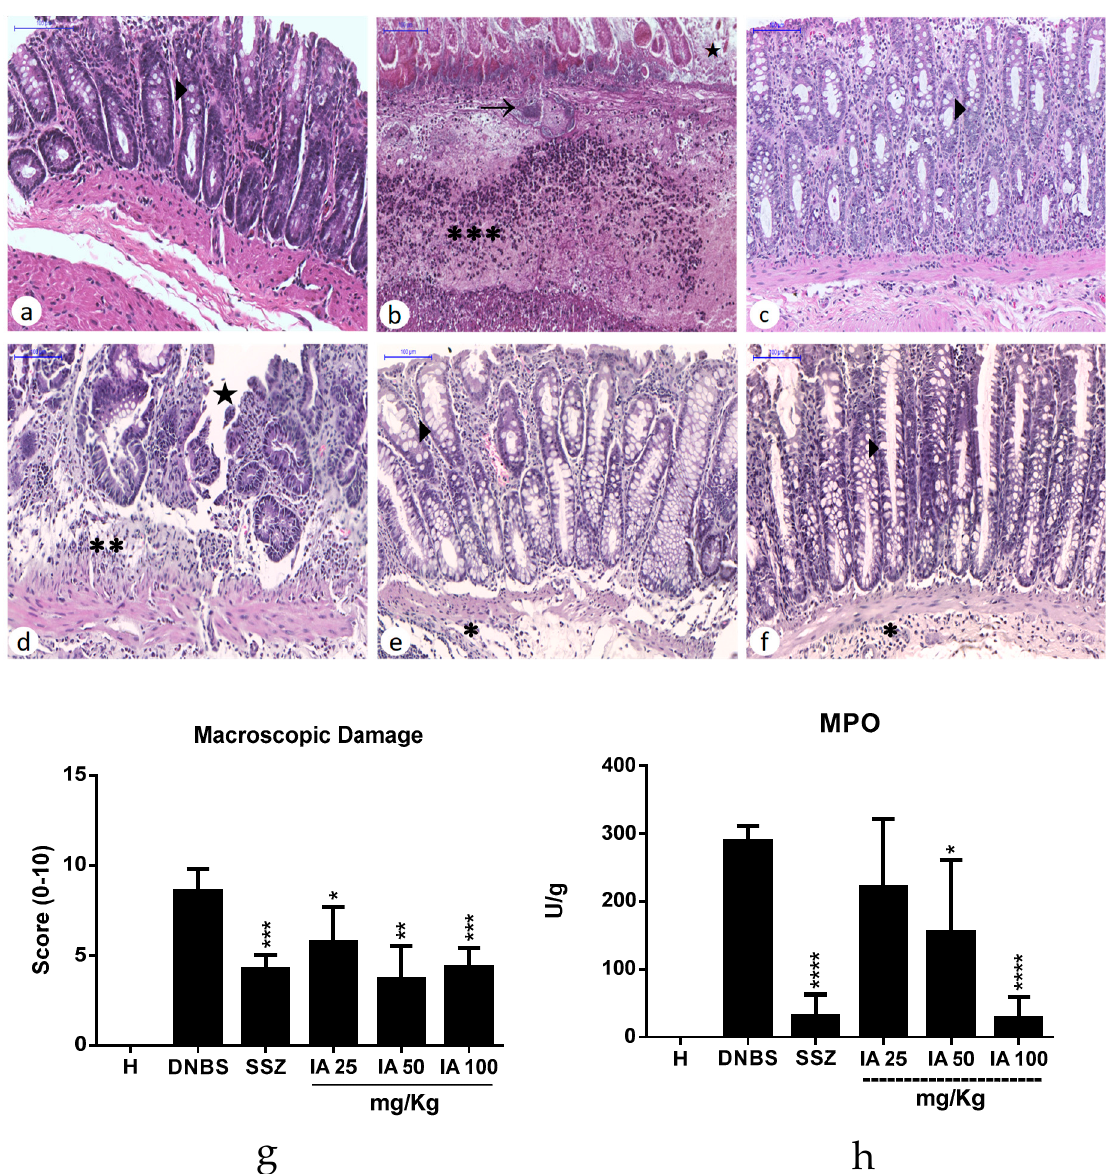
Figure 5. Histopathological analysis of the effect of the I. asarifolia (IA) aqueous extract at doses of 25, 50, and 100 mg/kg, and sulfasalazine (SSZ) at 250 mg/kg on intestinal colon mucosa in the experimental trial of acute colitis induced by 2,4-dinitrobenzene sulphonic acid (DNBS) in rats. Healthy group ( a ), exhibiting normal colonic mucosa with the presence of intact epithelium and numerous goblet cells; DNBS group (DNBS) ( b ), demonstrating the loss of epithelial integrity, intense inflammatory infiltrate ( ∗∗∗ ), focal necrosis ( → ) and ulceration ( (cid:70) ); Sulfasalazine group ( c ), with characteristics similar to the saline group; IA dose of 25 mg/kg ( d ) presented areas with loss of epithelial integrity and moderate inflammatory infiltrate ( ∗∗ ); IA dose of 50 mg/kg ( e ) and IA dose of 100 mg/kg ( f ) exhibited better organized colonic epithelial tissue, similar to the saline group, and presented areas with loss inflammatory infiltrate ( ∗ ). The arrow heads ( ► ) represent the goblet cells. Microscopic score of treatments vs. DNBS control ( g ). Myeloperoxidase activity (MPO) ( h ). H, Healthy group; DNBS, DNBS group; SSZ, Sulfasalazine group; and 25, 50, and 100 mg/kg doses of IA. Data are expressed as mean ± SEM, ( n = 5). Statistical differences * p < 0.05, ** p < 0.01, *** p < 0.001 and **** p < 0.0001 of treatments vs DNBS control were presented (Scanner Panoramic Viewer, 100×).